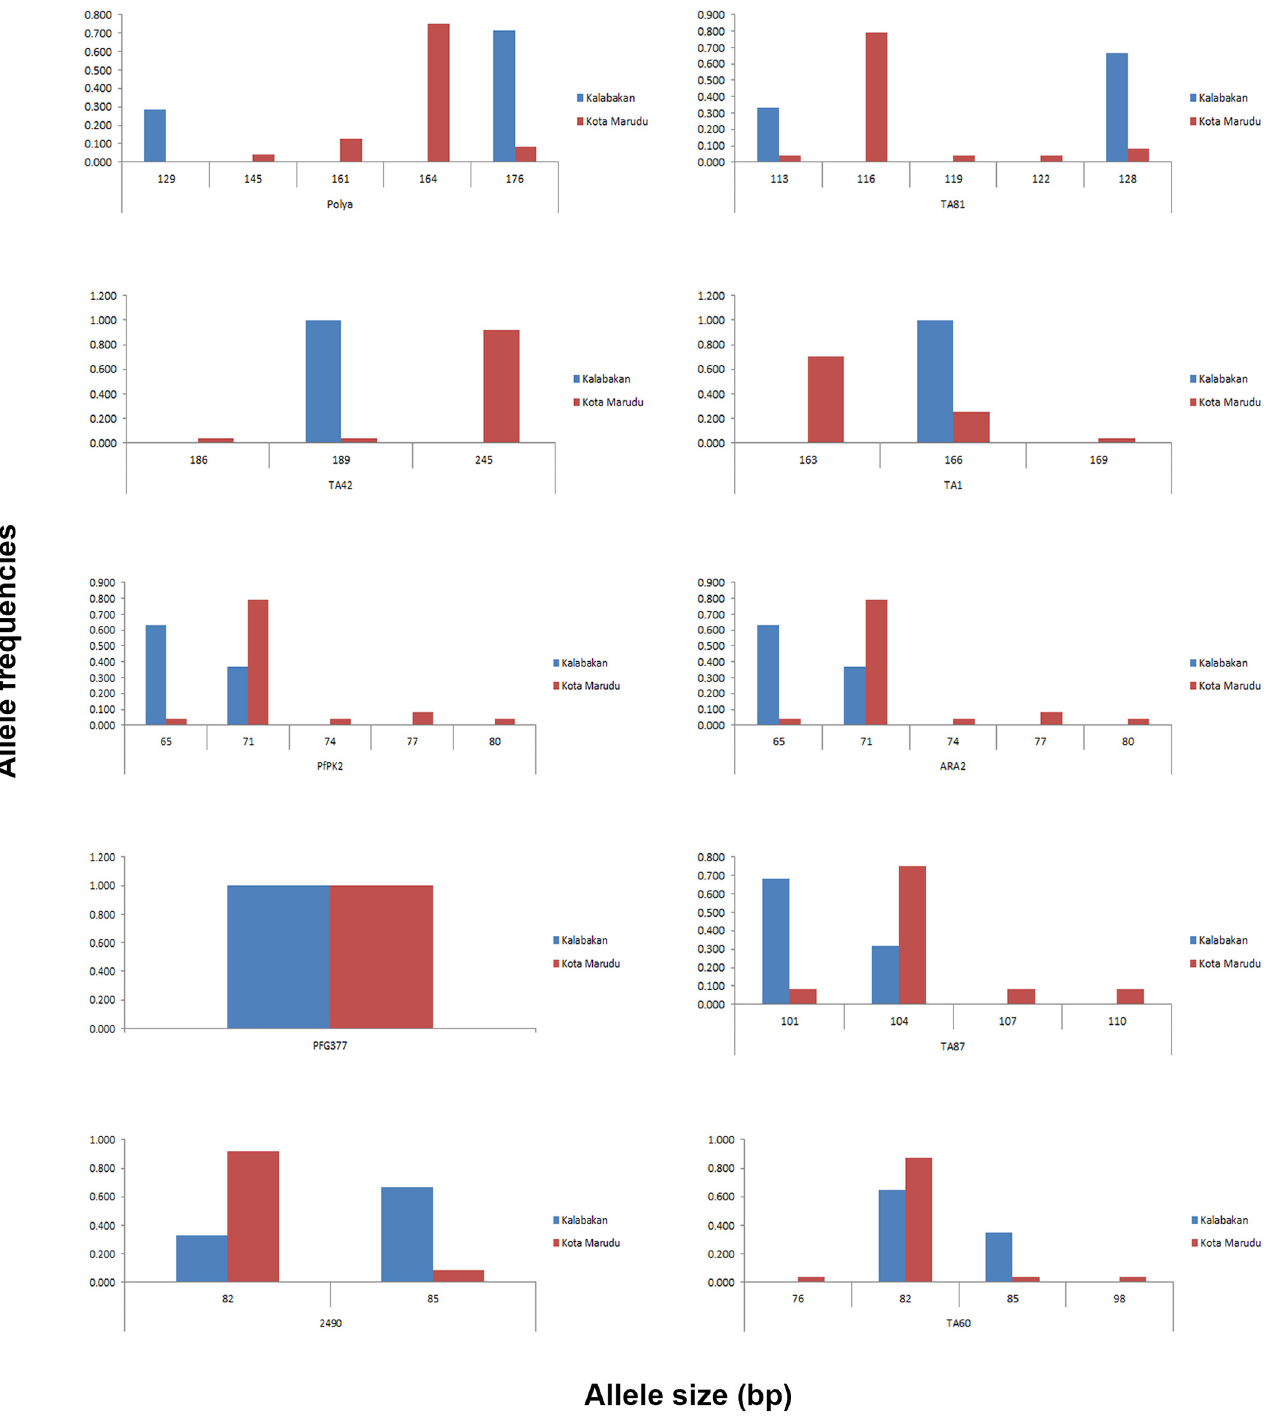
Fig 2. The allele frequencies of 10 microsatellite loci in the Kalabakan and Kota Marudu P . falciparum isolates. Allele sizes, determined by fragment analysis, are shown on the x-axis and their frequencies on the y-axis. Vertical bars for allele frequencies of each microsatellite locus were determined using GENALEX 6.0. Only 1 allele (96 bp) was detected on PFG377 locus for both Kalabakan and Kota Marudu P . falciparum isolates (S1 Table).